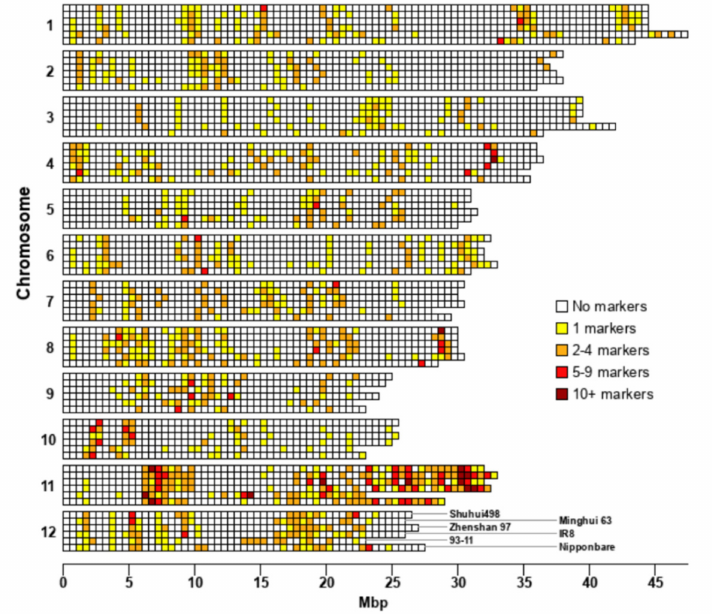
Figure 1. Genomic distribution of identified R-genes and R-pseudogenes. Chromosome lengths differ for each reference genome and adjacent blocks do not represent genomic